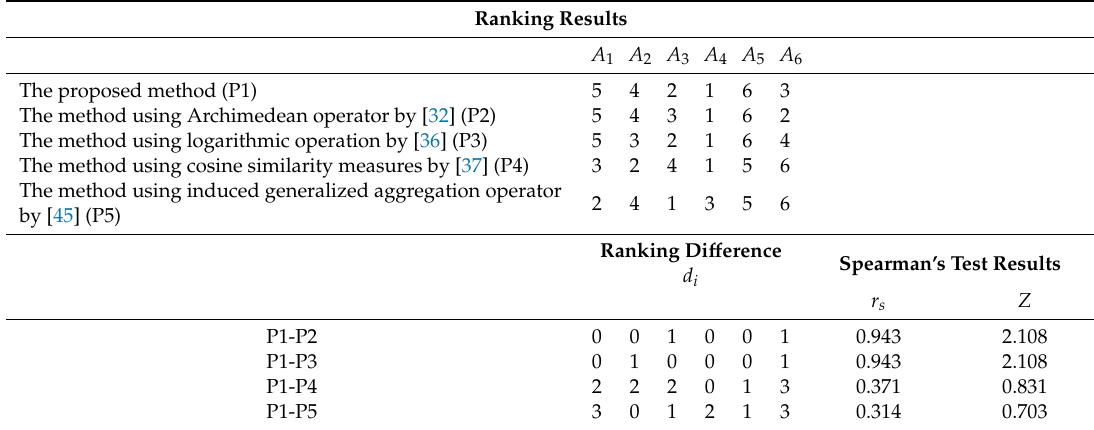
Table 6. Spearman’s rank-correlation test